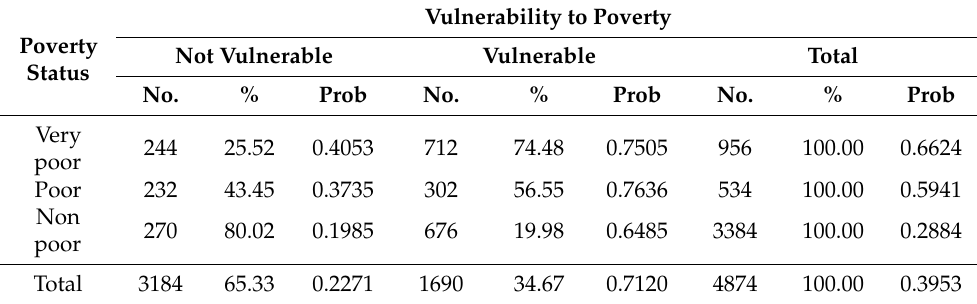
Table 10. Vulnerability with Social Expenditure,